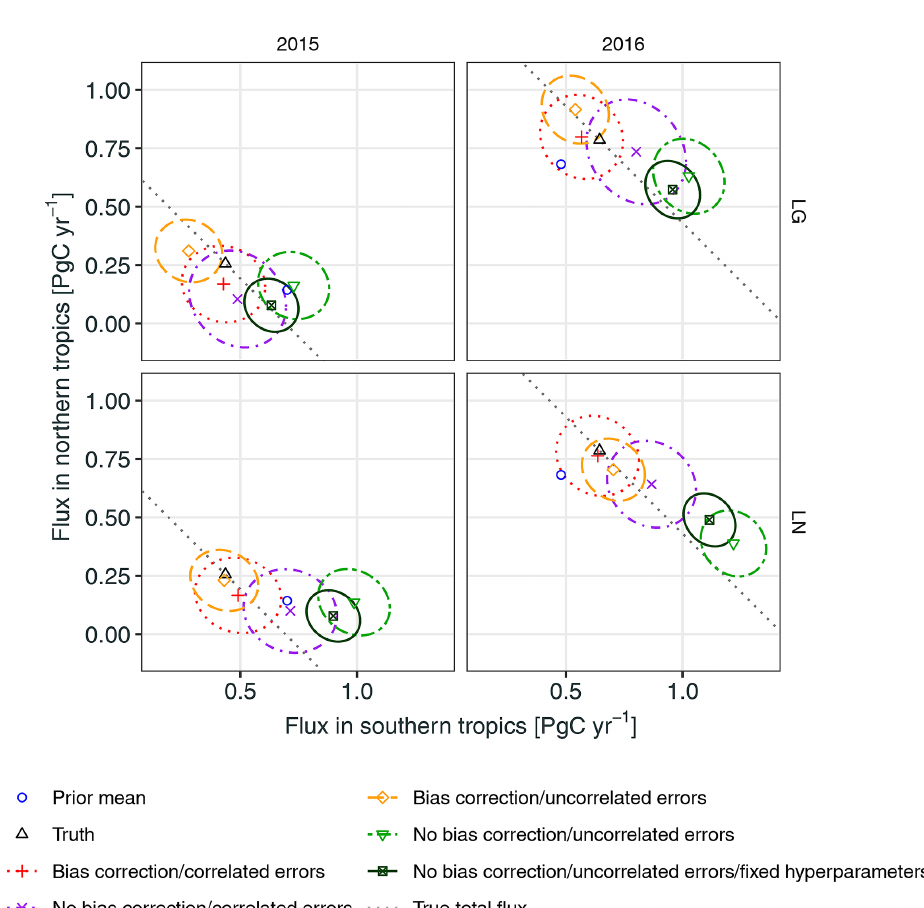
Figure 3. True, prior, and posterior estimates of total flux in the northern tropics (0 to 23.5 ◦ N) vs. the total flux in the southern tropics (23.5 ◦ S to 0 ◦ ) for the OSSE in Sect. 5.1. The columns correspond to the years 2015 and 2016, while the rows show which observation groups were used, either OCO-2 land glint (LG) or land nadir (LN), noting that the prior and true flux are the same across rows. Points show the posterior mean fluxes for each model configuration, as well as the prior mean in blue and the truth in black. The ellipses contain 95% of the posterior probability for the true tropical fluxes in the Southern Hemisphere and the Northern Hemisphere. The dotted grey lines along the diagonal correspond to combinations of southern and northern tropical fluxes that yield the true total flux in the tropics. All fluxes are exclusive of fossil fuels, which are held fixed in the